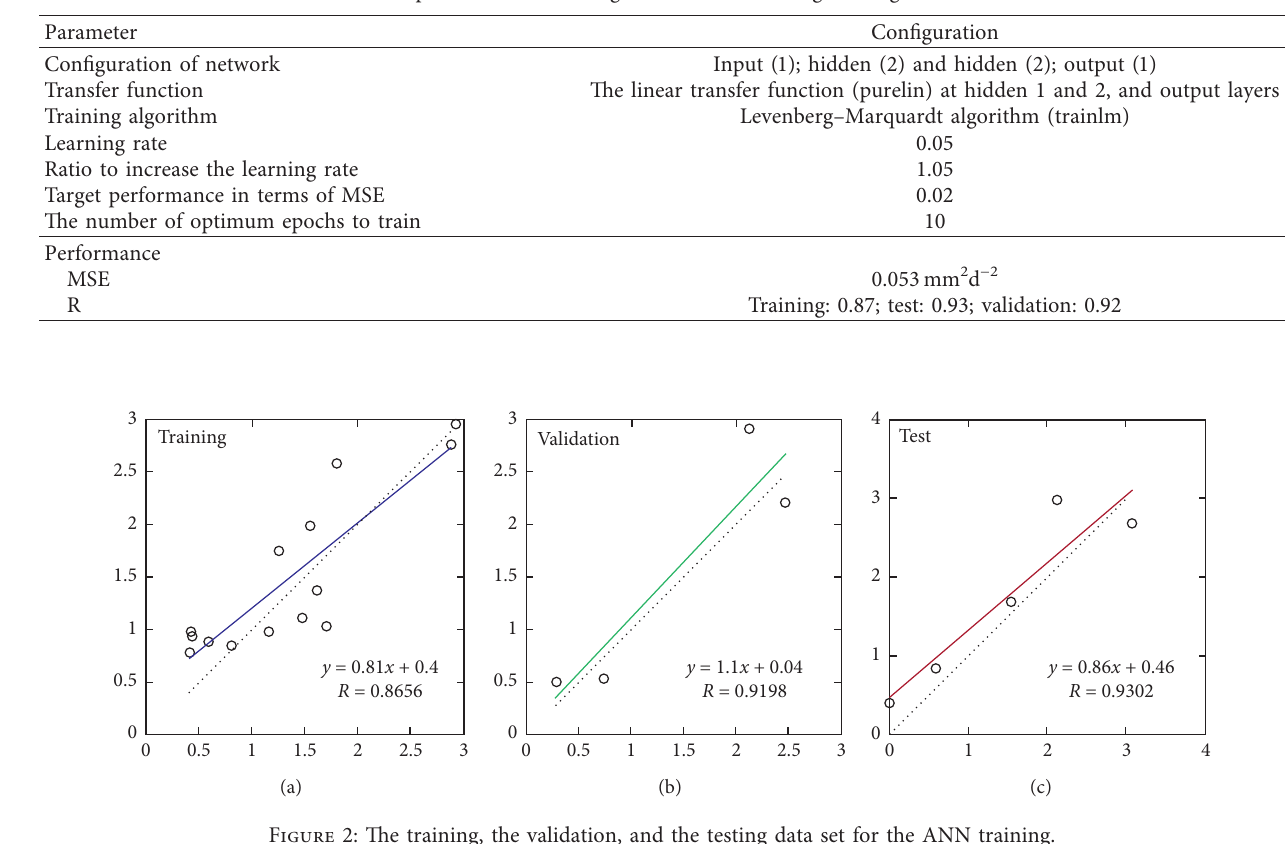
Table 1: ANN parameters and configuration for estimating missing rainfall